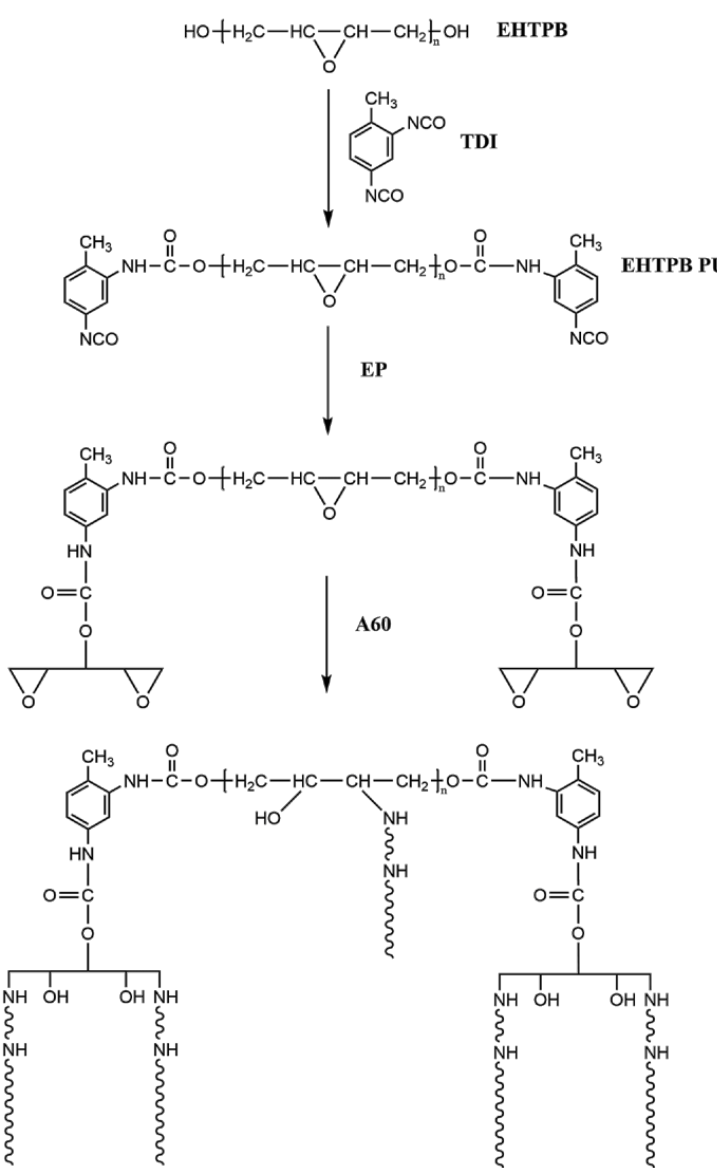
Figure 1. Preparation principle of the EHTPB-modified epoxy resin.